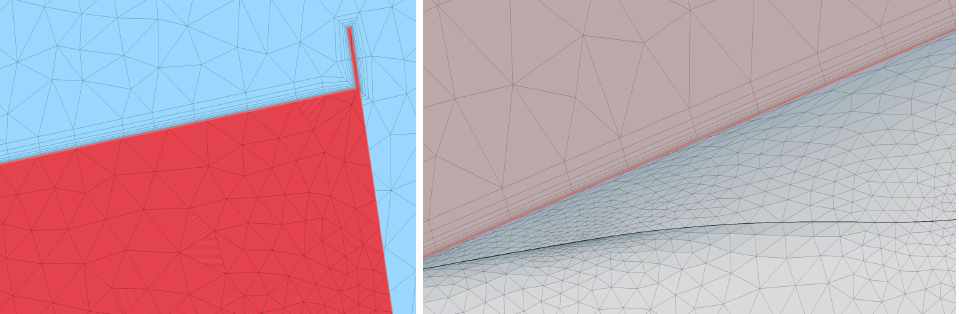
Figure 14. Details of the boundary layers and local refinements.